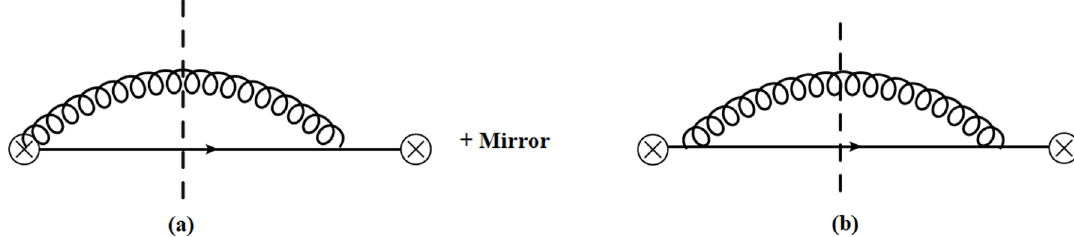
Figure 2. Real emission diagrams for vacuum jet function at the amplitude square level. The dashed line indicates the cut. Diagram (a) has a real gluon emission from the collinear Wilson line attached to the hard vertex which creates the initiating n quark, denoted by ⊗ along with a single insertion from H which describes interactions between n collinear partons. Diagram (b) comes n, int from two insertions of H . Since this is vacuum evolution there are no Glauber exchanges with n, int the medium